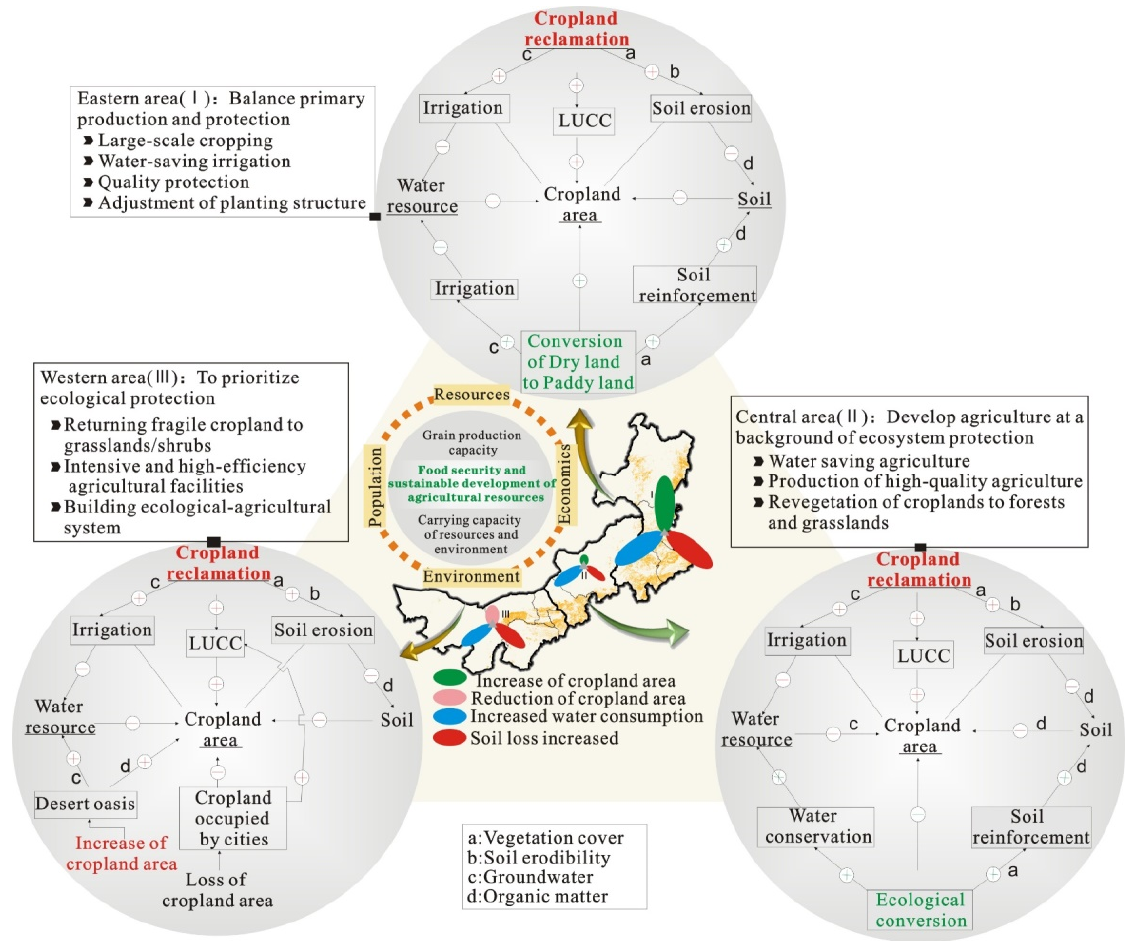
Figure 8. The paths for sustainable development of agriculture in Inner Mongolia.